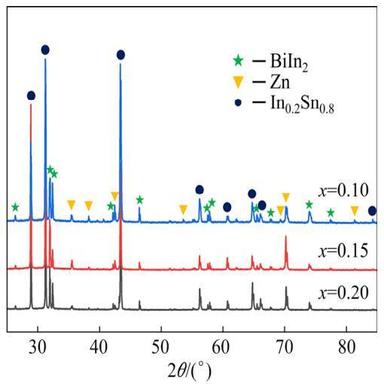
RD patterns of (Sn1−xZnx)57(In0.78Bi0.22)43 solder alloys